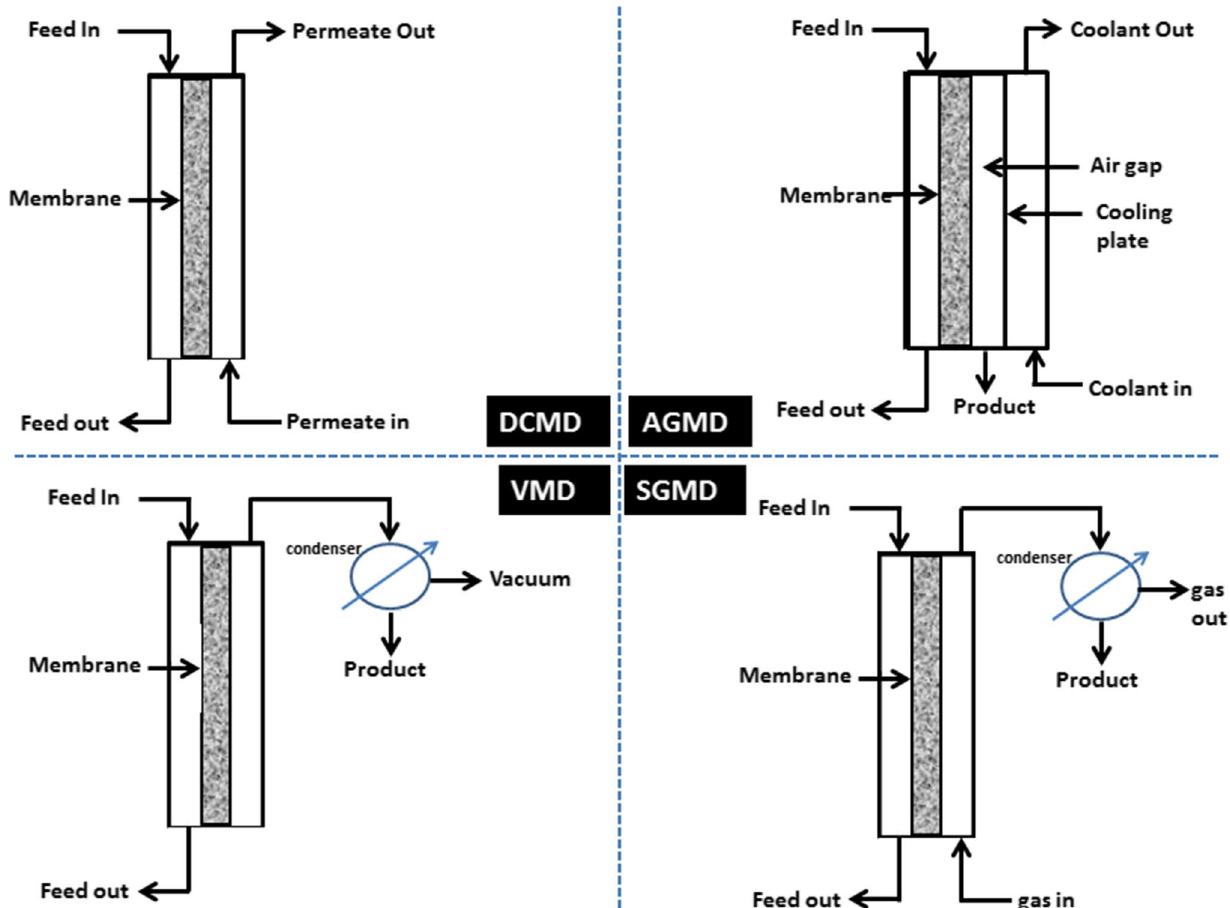
Fig. 1 Various MD configurations. (Adapted from (Khayet et al. 2003; Awad et al., 2013; Swaminathan et al.